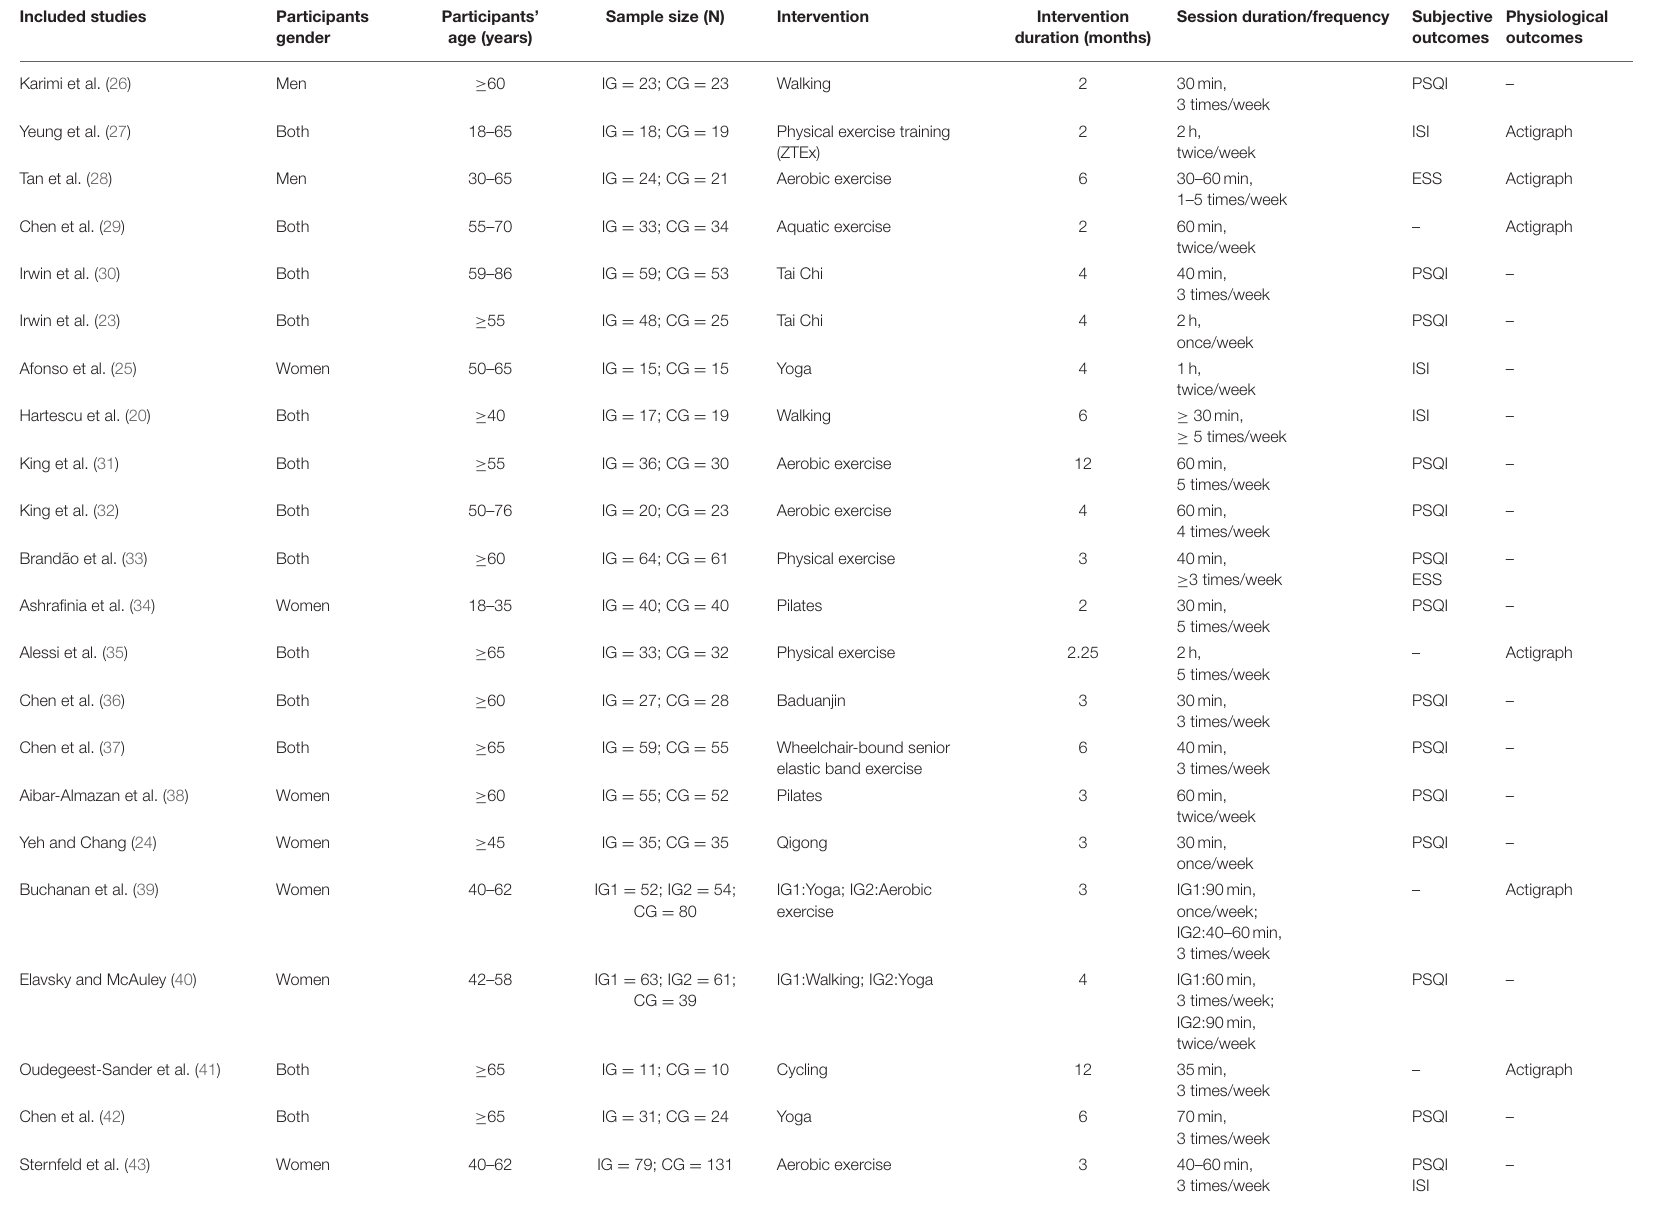
TABLE 1 | Characteristics of the included trials and